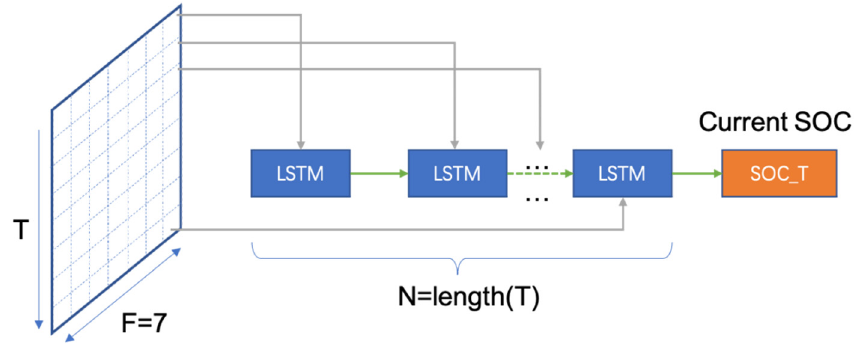
Figure 10. Our LSTM chain structure.